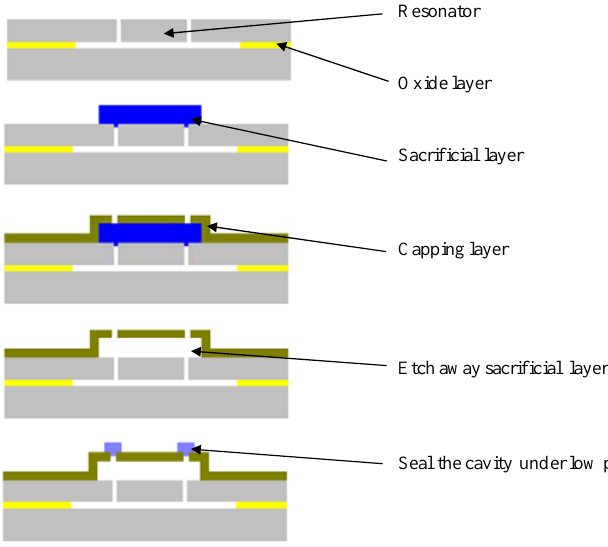
Figure 1. An example of a production method for a